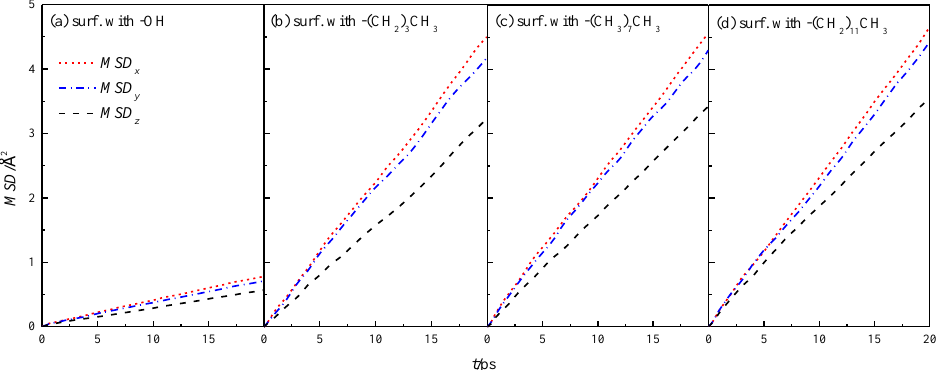
Figure 5. MSD in the x, y, and z directions of water in a nanochannel with different surface characteristics.